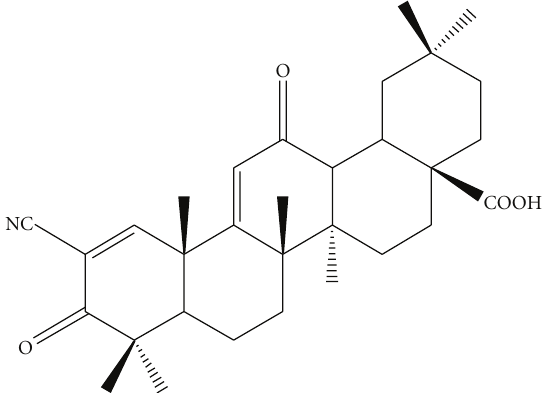
Figure 1: Molecular structure of CDDO 2-cyano-3,12- dioxooleana-1,9-dien-28-oic acid (CDDO).